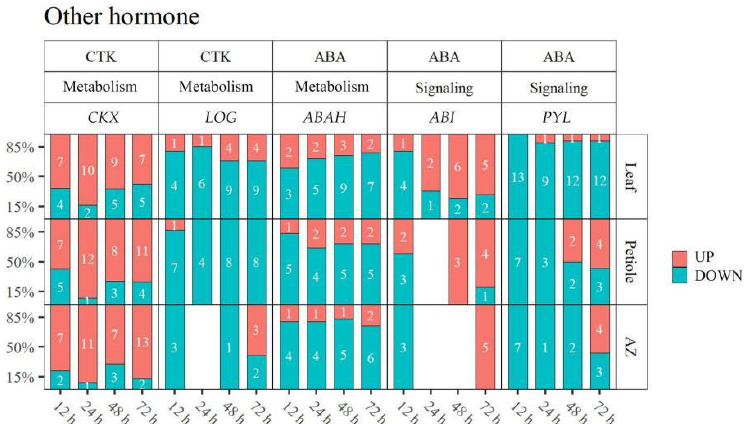
Figure 9. TDZ regulates the gene expression of metabolism and signal related to CTK and ABA. DEGs were determined between 12 h and 0 h, 24 h and 0 h, 48 h and 0 h, 72 h and 0 h, respectively. The DEGs were controlled by FDR<5% and |log2Fc|≥1. White digits indicate the gene